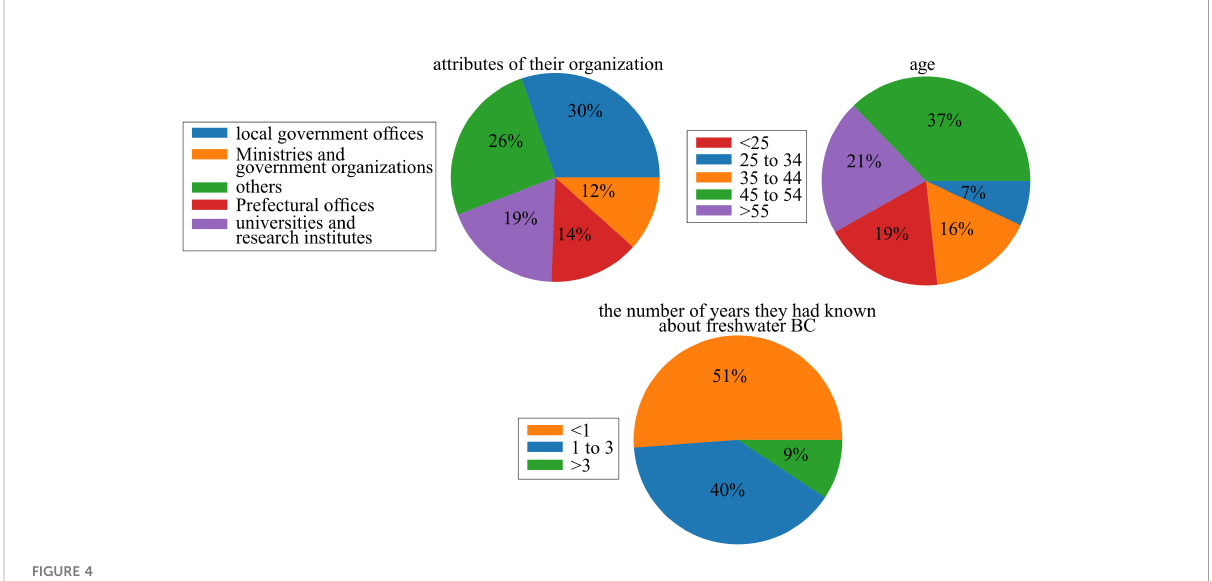
FIGURE 4 Respondent attributes in the results regarding freshwater